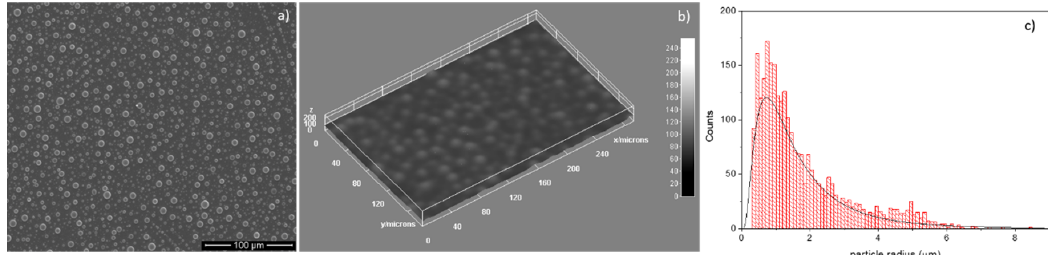
Figure 5. ( a ) Survey SEM image of HApCs coatings generated at 5 × 10 − 3 mbarr Ar gas working pressure; ( b ) 3D image of Figure 1 performed with ImageJ software; ( c ) histogram of particle sizes.